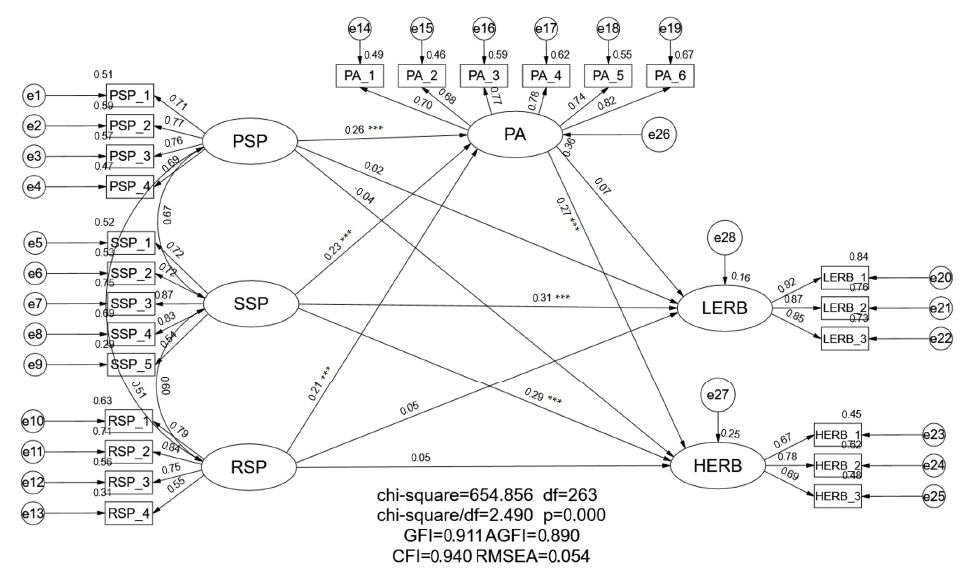
Figure 3. Structure diagram of load and path coefficient.